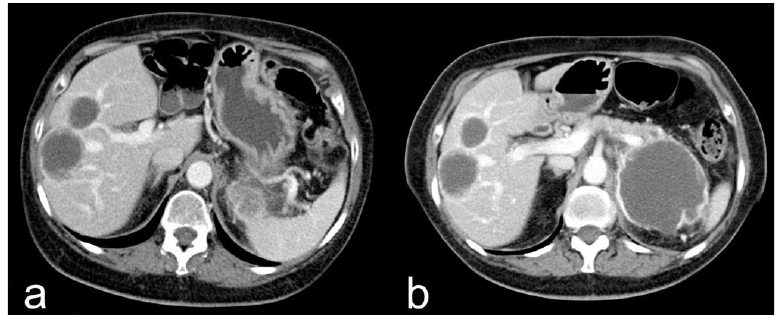
Figure 3. Contrast-enhanced CT axial scan during the venous phase of a 67-year-old female mRCC patient, showing 2 cystic hepatic metastases ( a ). The lesions showed SD at follow-up with dimensional stability after ICI treatment ( b ).